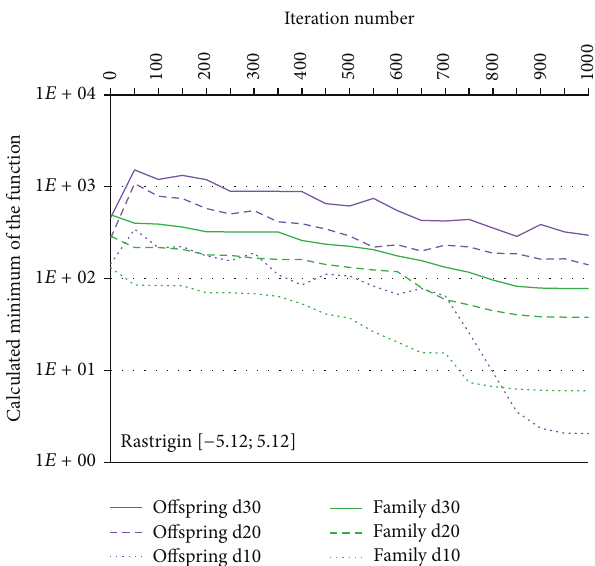
Figure 10: The exIWO convergence plot for the Rastrigin function using offspring-based or family-based selection.